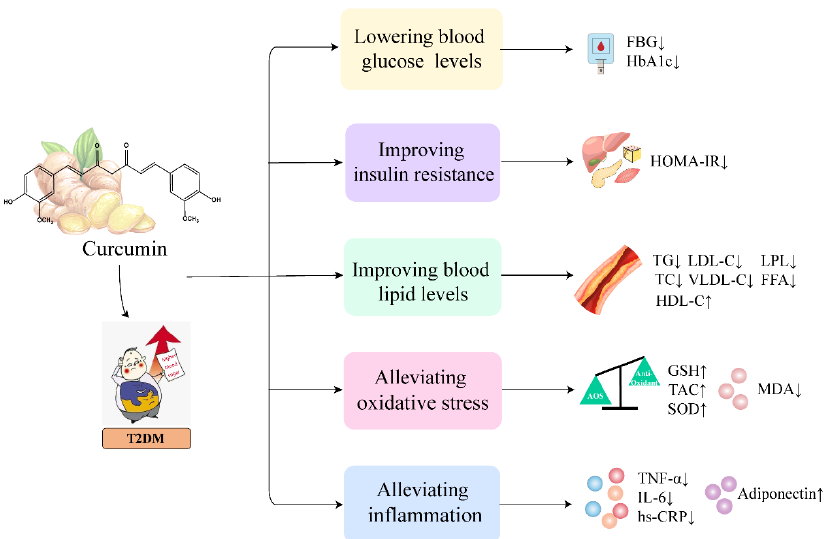
Figure 2. The therapeutic effects and potential mechanisms of curcumin on T2DM. ↑ indicates increase and ↓ indicates decrease. Specifically, curcumin can lower blood glucose and lipid levels and improve insulin resistance. Moreover, curcumin alleviates inflammation by decreasing the levels of IL-6, TNF- α and hs -CRP, and increasing the anti-inflammatory cytokine adiponectin. Curcumin alleviates oxidative stress by decreasing the levels of MDA and increasing the expression of antioxidants, including SOD, GSH and TAC. including SOD, GSH and